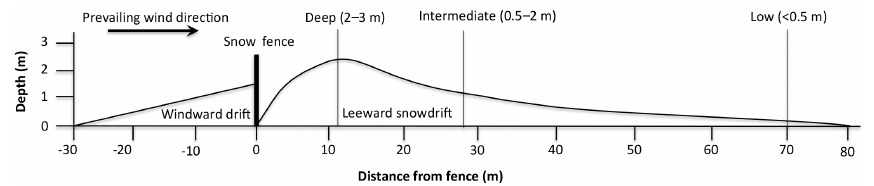
Figure 1. Modified from Walker et al. (1999). Schematic of snow accumulation depth at moist acidic tundra site from snow fence manipu- lation. Three soil cores were obtained from each treatment zone (labelled Deep, Intermediate, and Low) and a control zone located > 30m outside the effect of the snow